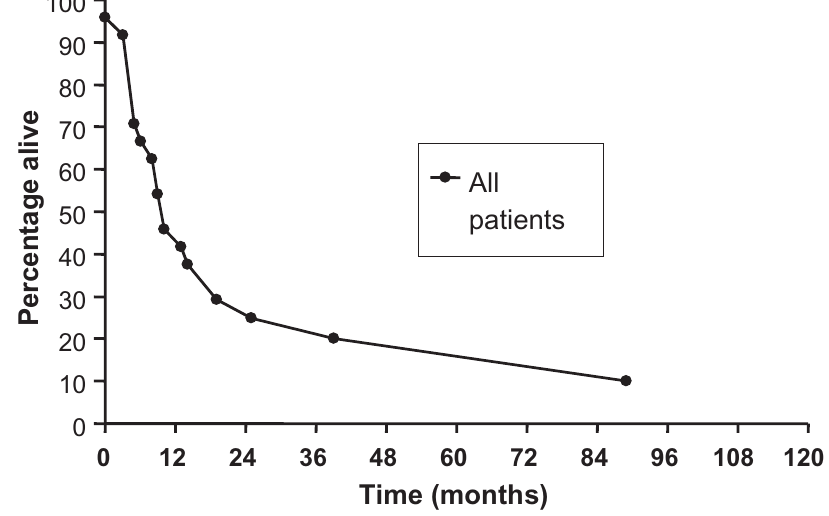
Fig. 1. Kaplan–Meier survival curve of overall survival for all patients. Note that the median survival is 10 months and that no plateau has yet to be